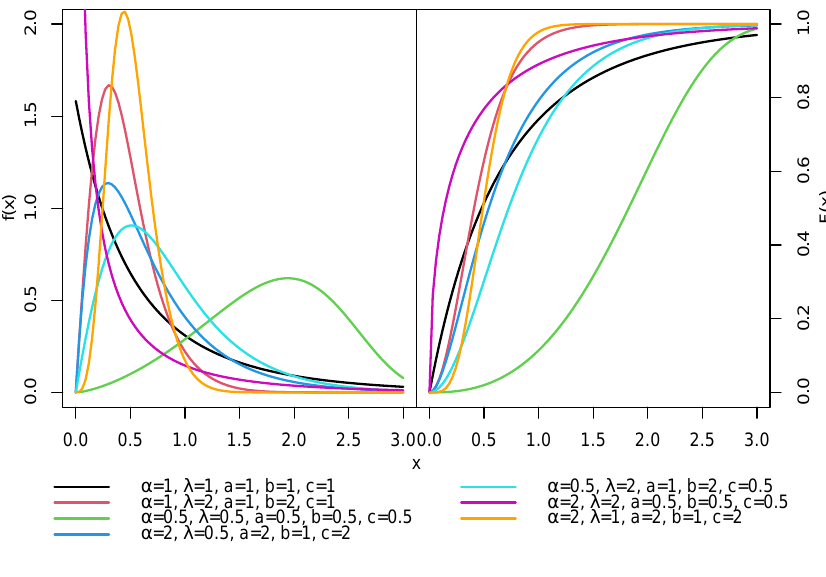
Figure 2 – PDF (left panel) and CDF (right panel) of McWP